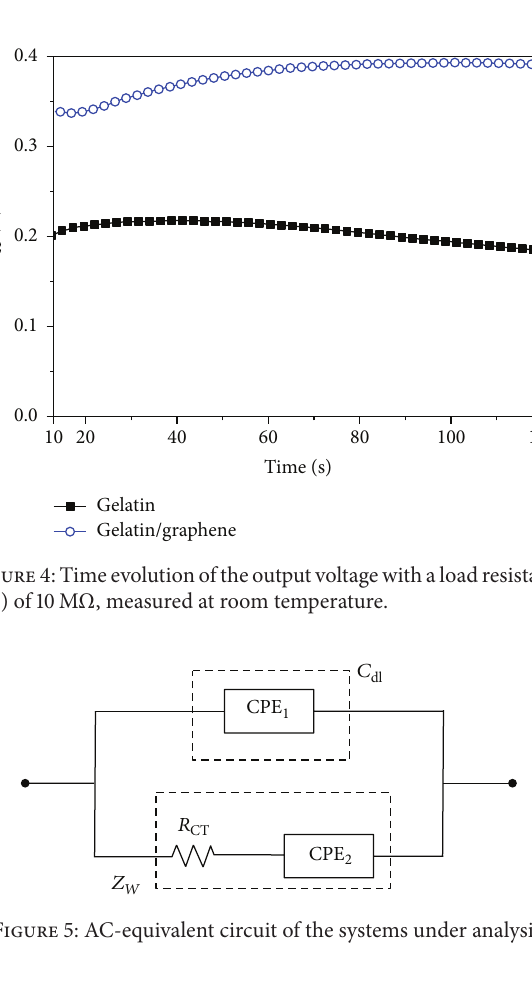
layers of graphene reduces the overall resistance by 50%, thus producing a strong enhancement of the output voltage.